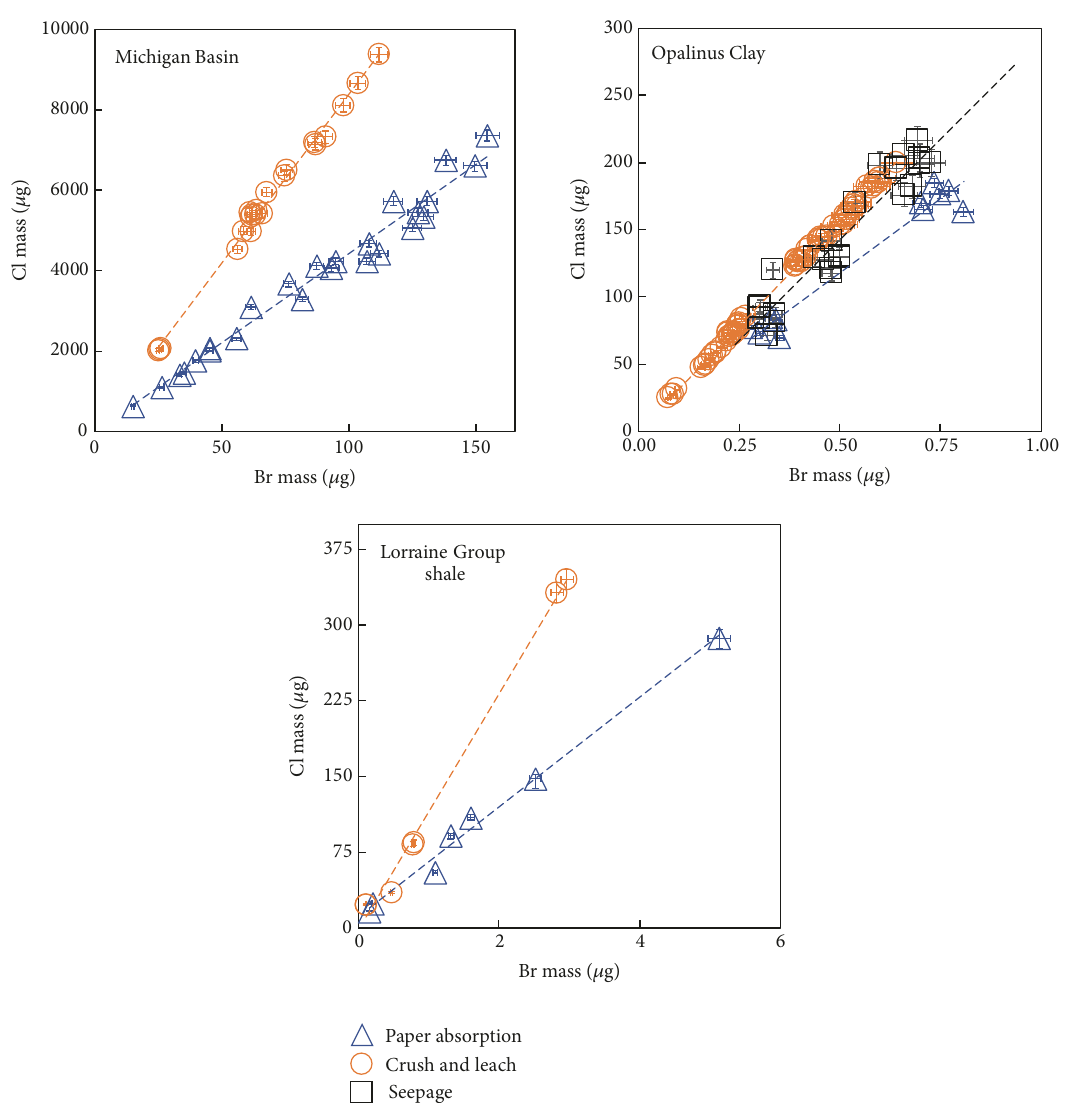
Figure 2: Cl − versus Br − mass extracted using the paper-absorption and crush-and-leach methods for rock cores from the Michigan Basin, Opalinus Clay, and the Lorraine Group. Scaling factors of 10, 20, and 3.5, respectively, were applied to the masses extracted by crush and leach to allow for direct comparison between methods. A scaling factor of 50 was applied to the solute masses (L −1 ) in the seepage water collected from boreholes in Opalinus Clay by Pearson et al. [29]. Error bars represent the instrumental error on solute